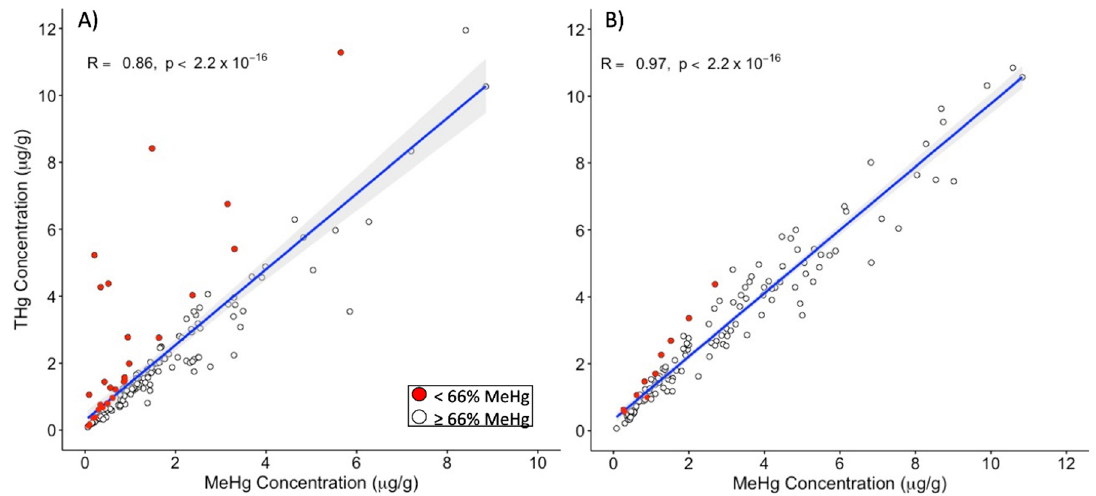
Figure 3. Scatterplots of Pearson correlations between hair THg and MeHg for individuals living within mining activity ( A ) and outside of mining activity ( B ). The blue line indicates a linear trend with the 95% confidence interval shaded in grey. Individuals with hair %MeHg < 66% are highlighted in red.